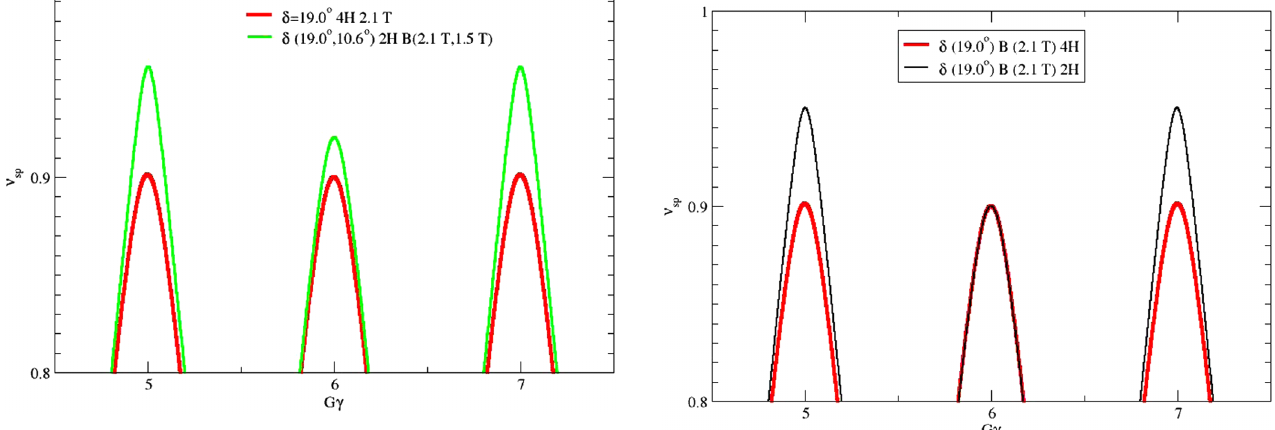
FIG. 7. The fractional part of the spin tune generated by four helices (red curve) each at a field of 2.1 T, and by two helices (black curve) of 2.1 T